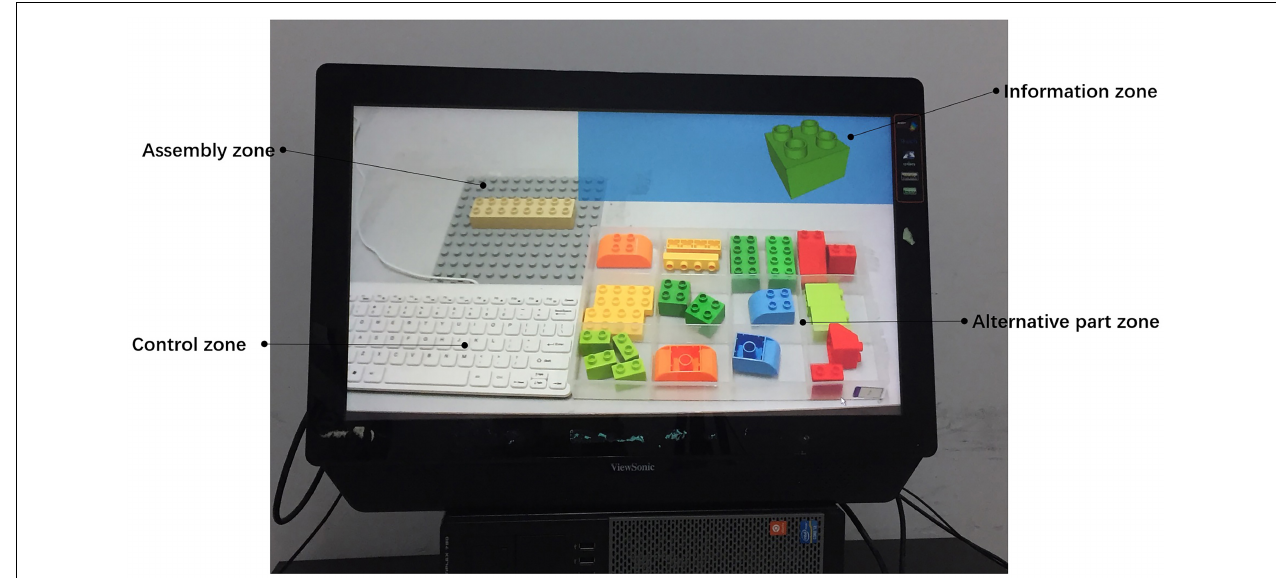
FIGURE 3 | Zoning on display.